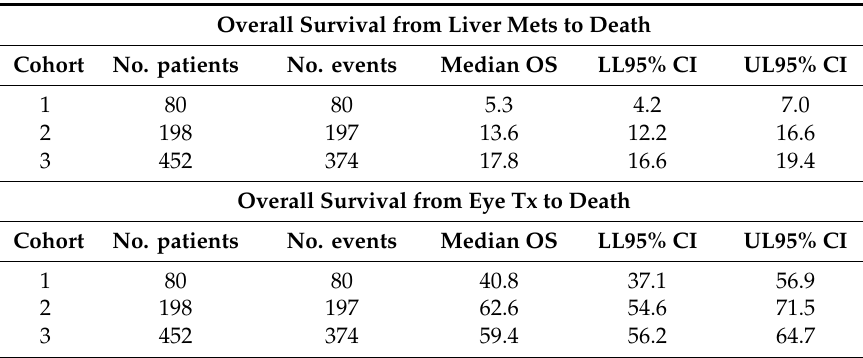
Table 4. Median overall survival in months by